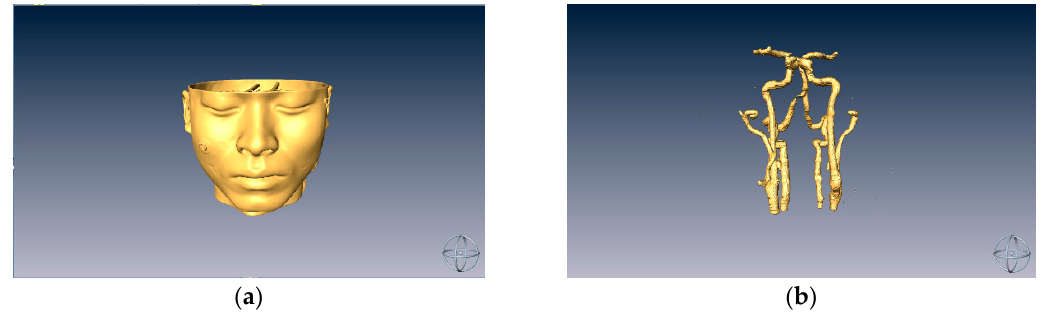
Figure 1. ( a ) A dummy head model; and ( b ) model of intracranial vascular tissue.